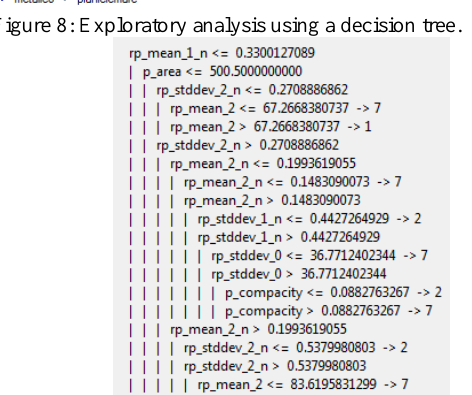
Figure 9: Model of a decision tree generated at GeoDMA